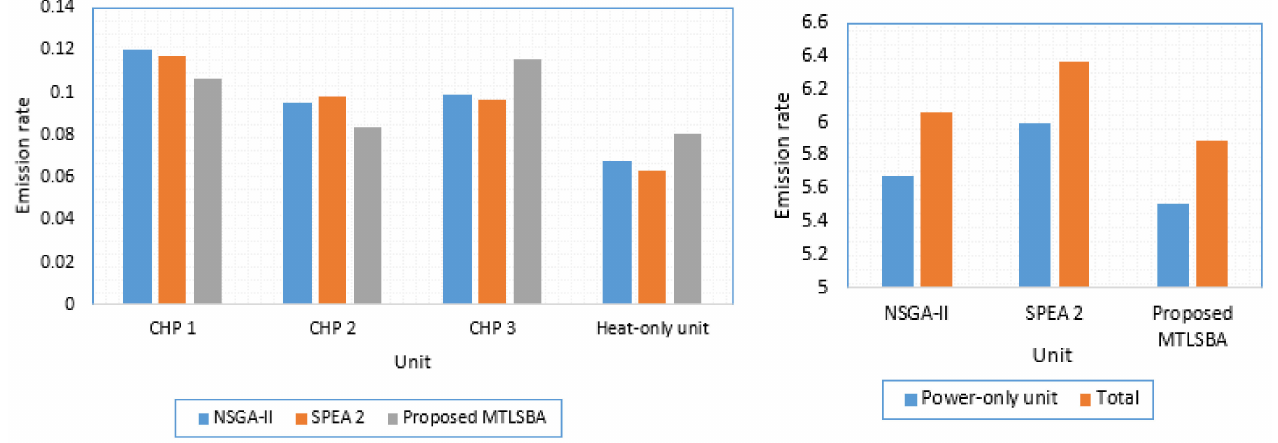
Figure 10. Emission rates for each unit related to the best compromise results in Table